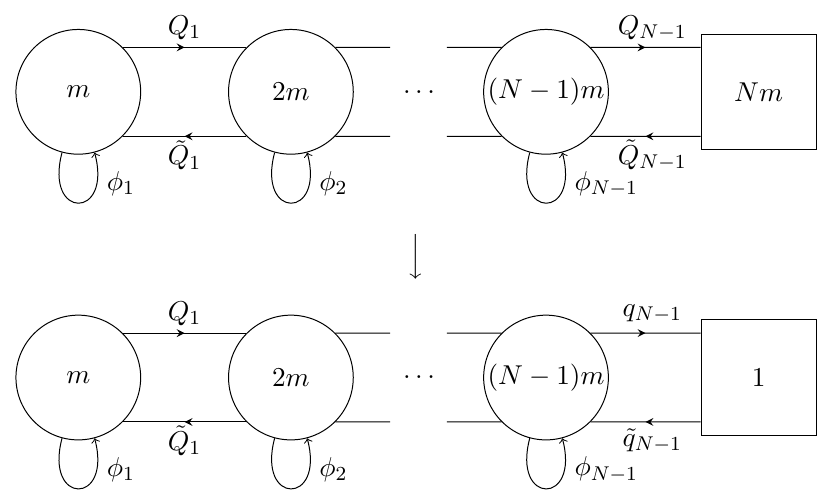
Figure 7. The upper figure is the UV quiver with matter content summarized in table 2, and the lower figure is the IR quiver with matter content summarized in table 3. The circles are special unitary gauge groups and the squares are flavor symmetry groups, where the upper square denotes SU( Nm ) and the lower square is meant to denote a global U(1) symmetry.